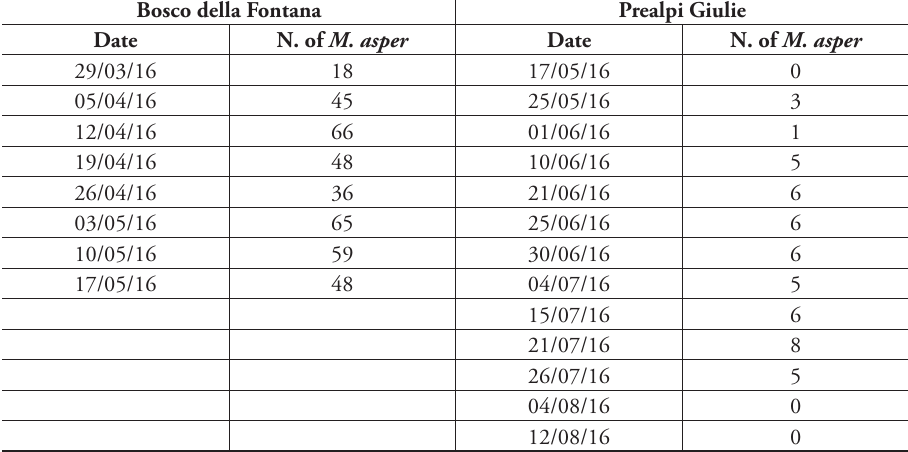
Table 1. Survey dates and numbers of M. asper observed for the two study sites. Bosco della